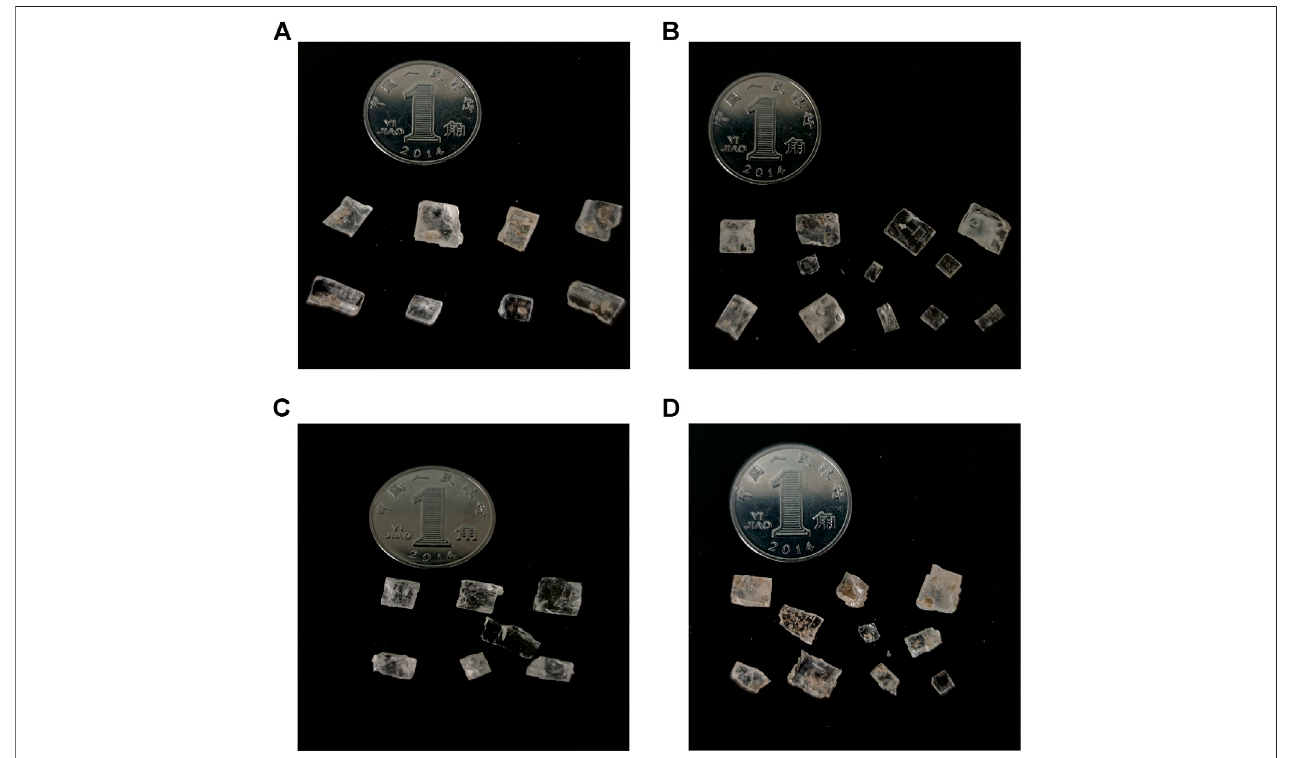
FIGURE 3 | Halite debris particles from the ISL1A drillhole. (A,D) Halite crystals and chips mixed with clay and silt that were prepared by cleaving 0.5 – 1 mm thickness with a razor blade. (B,C) Typical halite idiomorphic crystals and chips without clay and silt.